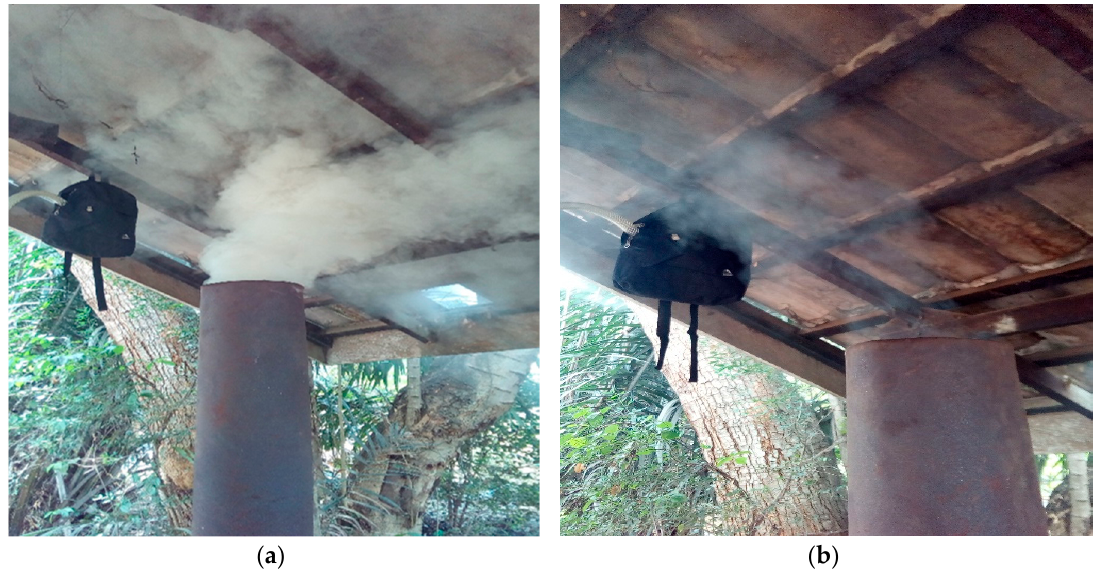
Figure 5. Smoke emissions from coconut wastes sun-dried for ( a ) 3 days and ( b ) 15 days.